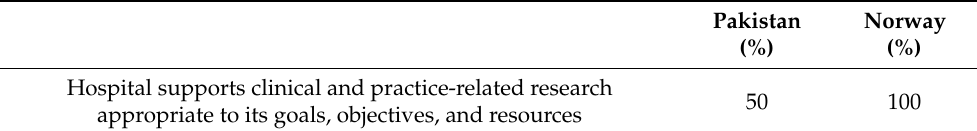
Table 11. Pharmacists’ assessments on